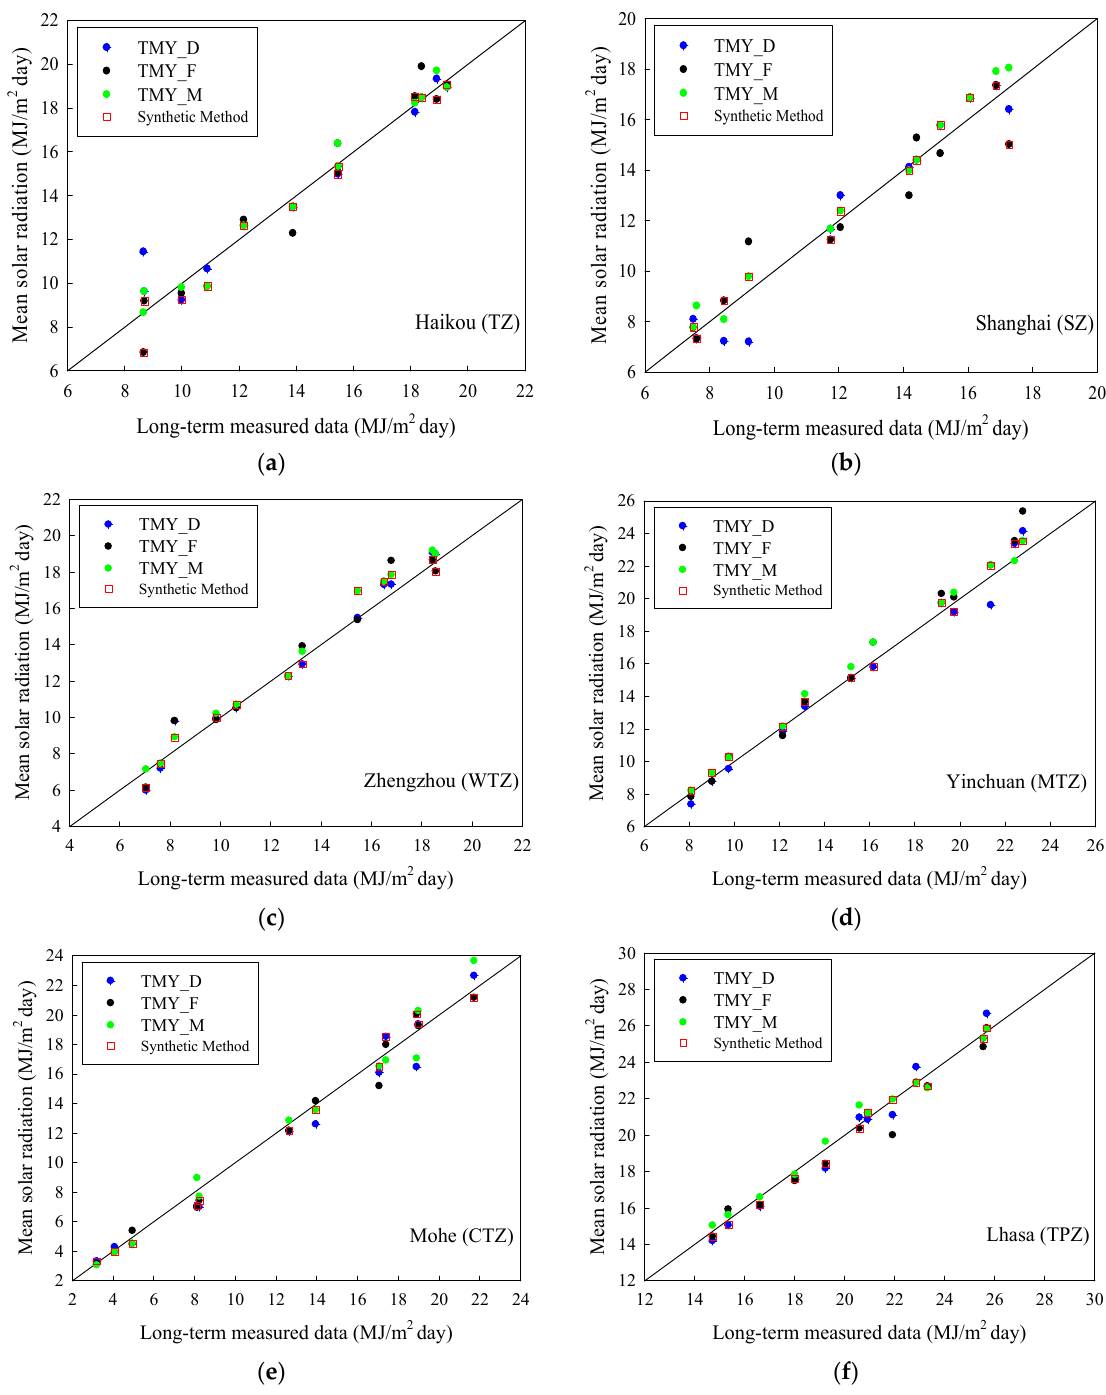
Figure 6. Comparing the long-term measured monthly mean solar radiation and the monthly mean solar radiation from TMYs using TMY_D, TMY_F, TMY_M and hybrid method for six typical climatic zones of China, at ( a ) Haikou; ( b ) Shanghai; ( c ) Zhengzhou; ( d ) Yinchuan; ( f ) Lhasa stations (1994–2015 measured data); and ( e ) Mohe station (1997–2007 measured data).